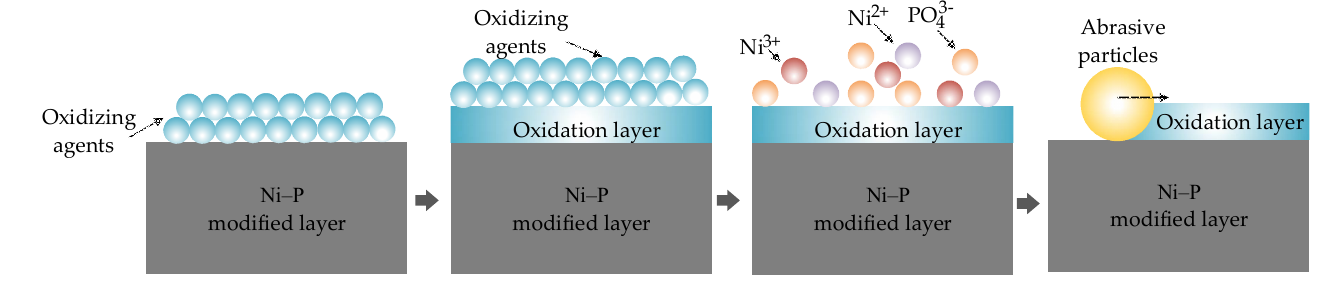
Figure 4. Principle of chemical reaction.